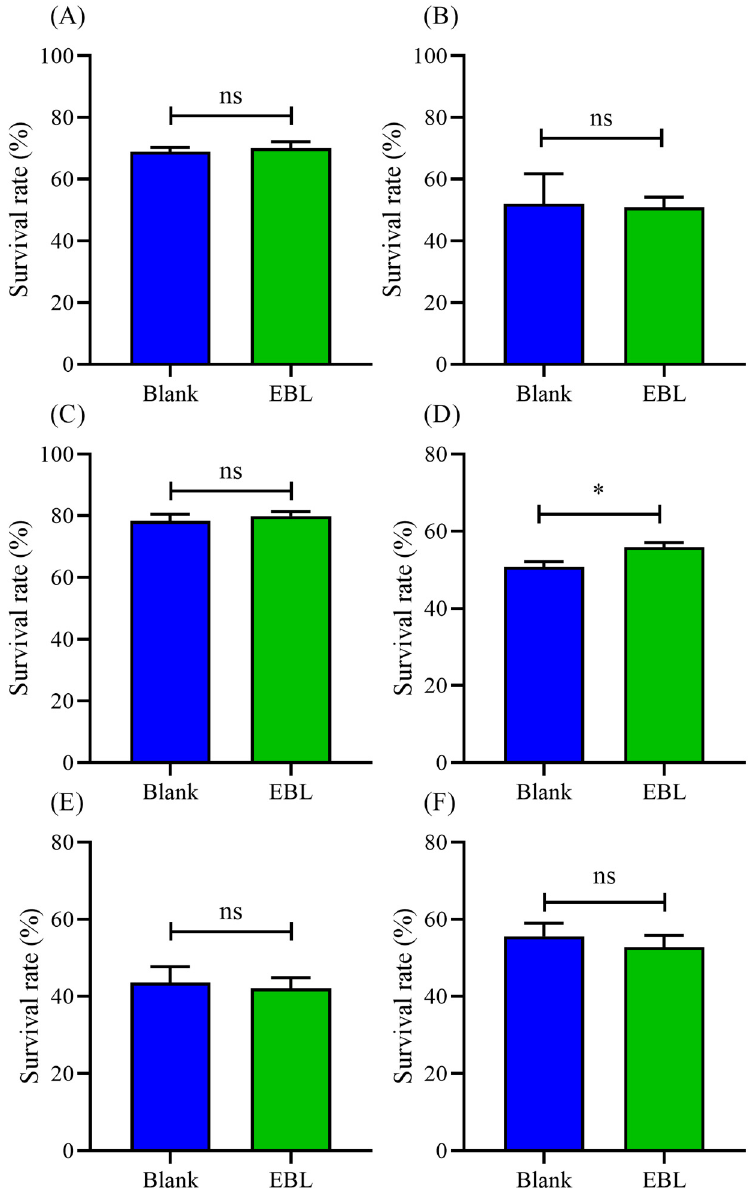
Figure 4. The survival of different mutants under thermal stress. ( A ) TJ1052 age-1 ( hx546 ), ( B ) CF1038 daf-16 ( mu86 ), ( C ) CB1370 daf-2 ( e1370 ), ( D ) EU1 skn-1 ( zu67 ), ( E ) VC204 akt-2 ( ok393 ), and ( F ) VC345 sgk-1 ( ok538 ). The concentration of EBL was 0.1 mg/mL. Note: * meant p < 0.05 and ns meant not significant.